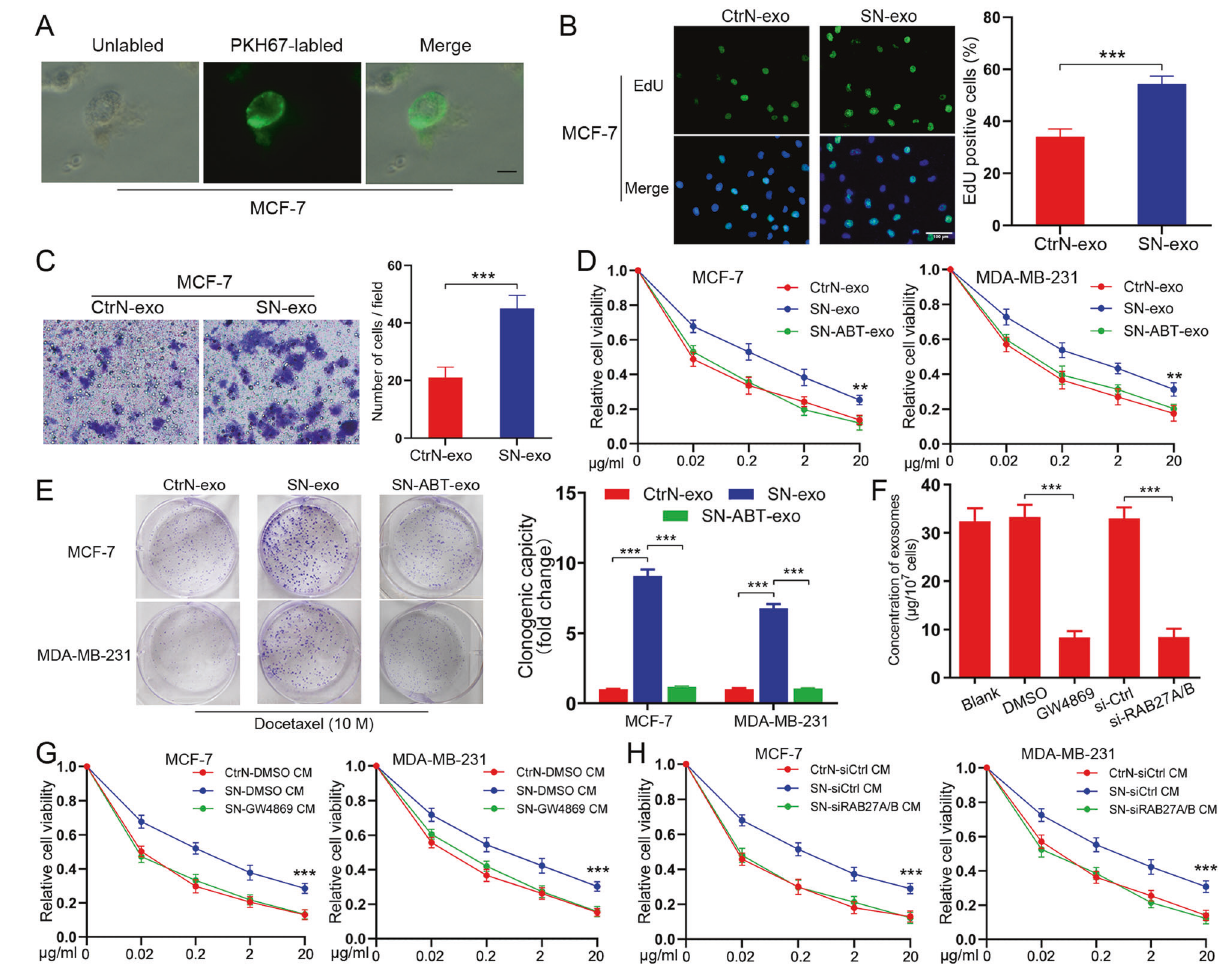
Fig. 2 Senescent neutrophils secret exosomes to promote the proliferation and chemoresistance of BC cells. A Representative confocal microscopy image showing the internalization of PKH67-labeled exosomes (green) by MCF-7 cells. Scare bars, 10 μ m. B Cell proliferation as measured by EdU incorporation was promoted by SN-exo in MCF-7 cells. Scare bars, 100 μ m. C Migration ability of MCF-7 cells was enhanced by SN-exo, tested by transwell assay. D CCK8 assay of BC cells pre-incubated with indicated exosomes for 48 h followed by docetaxel treatment at indicated concentrations for 48 h. E Colony formation assay of BC cells pre-incubated with indicated exosomes for 48 h followed by docetaxel at indicated concentrations for 48 h. F Quanti fi cation of the number of exosomes from senescent neutrophils with indicated treatments. G , H CCK8 assay of BC cells pre-incubated with indicated CM for 48 h followed by docetaxel at different concentrations for 48 h. Data represent the mean ± SD of at least three independent experiments. * P < 0.05, ** P < 0.01, *** P <